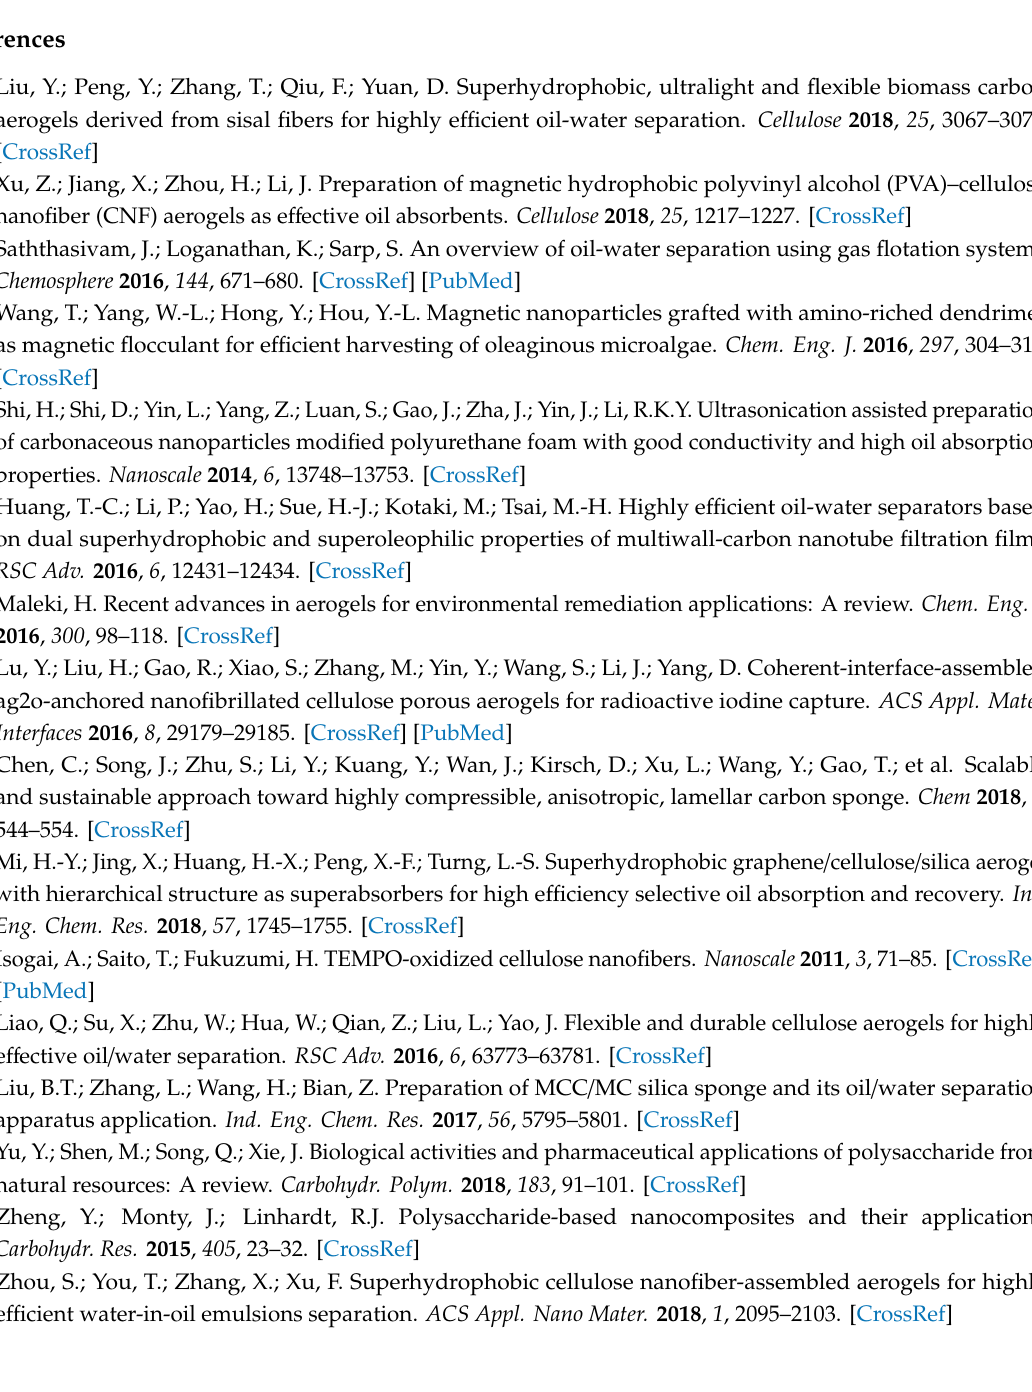
Figure S1: TGA curves of bleached fibers and TCNFs, Figure S2: The compression test of (a) original aerogel and (b) cross-linked aerogel, Figure S3: The photographs of the oil absorption by MTCS-modified aerogel, and Table S1: Comparison of the absorption capacities of di ff erent absorption aerogels made of nature